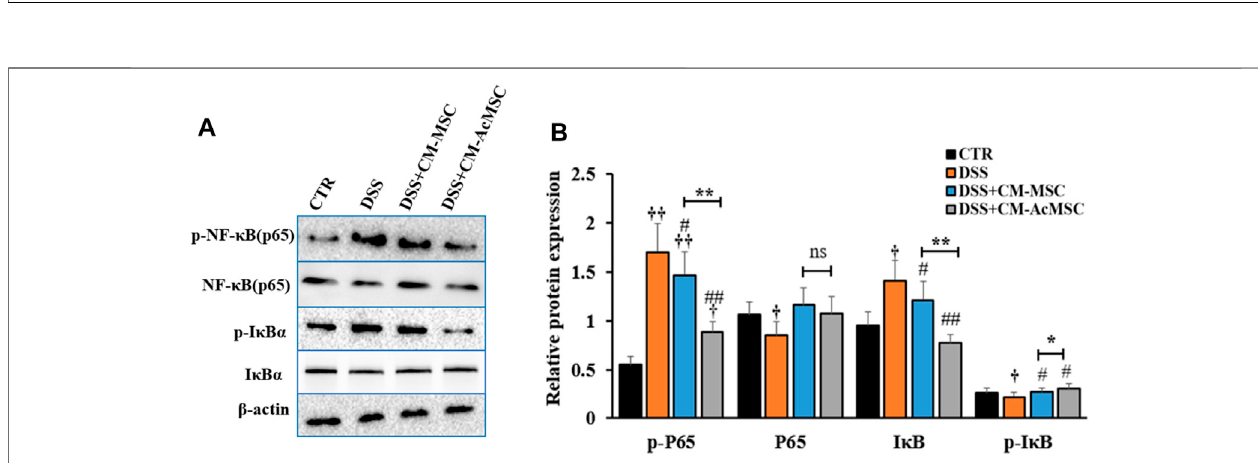
FIGURE 6 | CM-AcMSC inhibited the activation of NF- κ B signaling pathway in DSS induced colitis rats. (A) Changes of p-P65, P65, I κ B, p -I κ B, and β -actin were measured by western blot analysis. (B) Densitometric analysis was performed to evaluate the relative ratios of each protein. Data are presented as means ± SEM. † p < 0.05, †† p < 0.01 vs CTR; # p < 0.05, ## p < 0.01 vs DSS; * p < 0.05, ** p < 0.01. The same enhancement was applied to all sections of the WB to emphasize the bands.